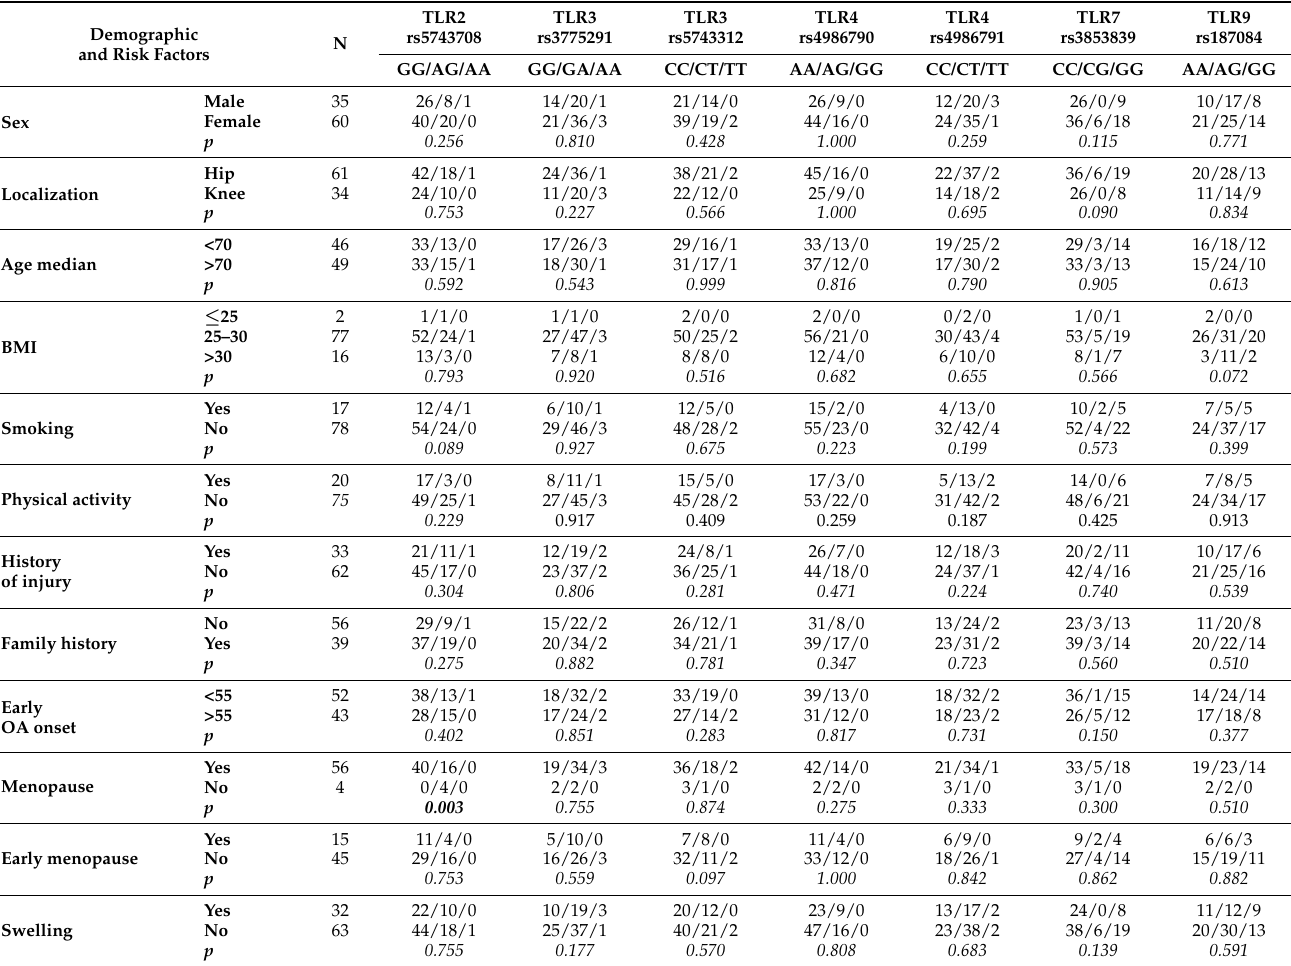
Table 2. TLR gene variant associations with demographic and clinicopathologic features in os- teoarthritis